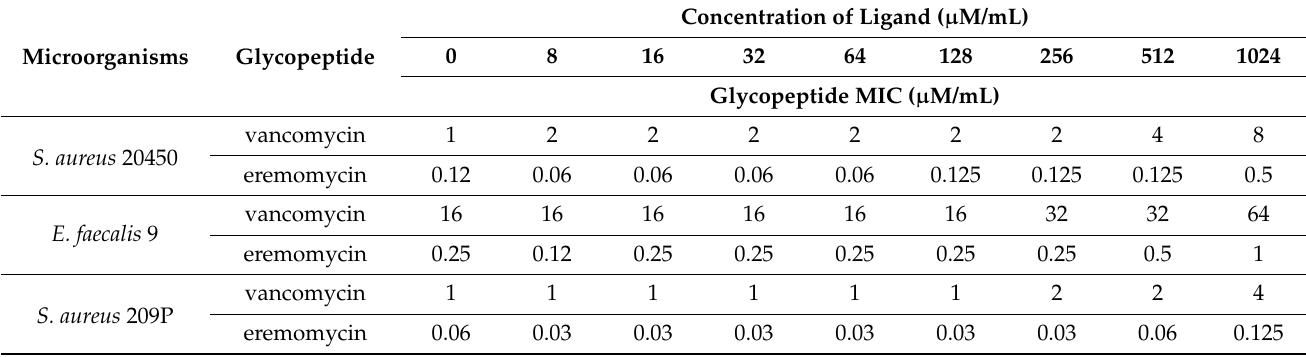
Table 1. Antibacterial activities of glycopeptides as influenced by the N -Ac- D -Ala- D -Ala dipeptide ligand (checkerboard method).